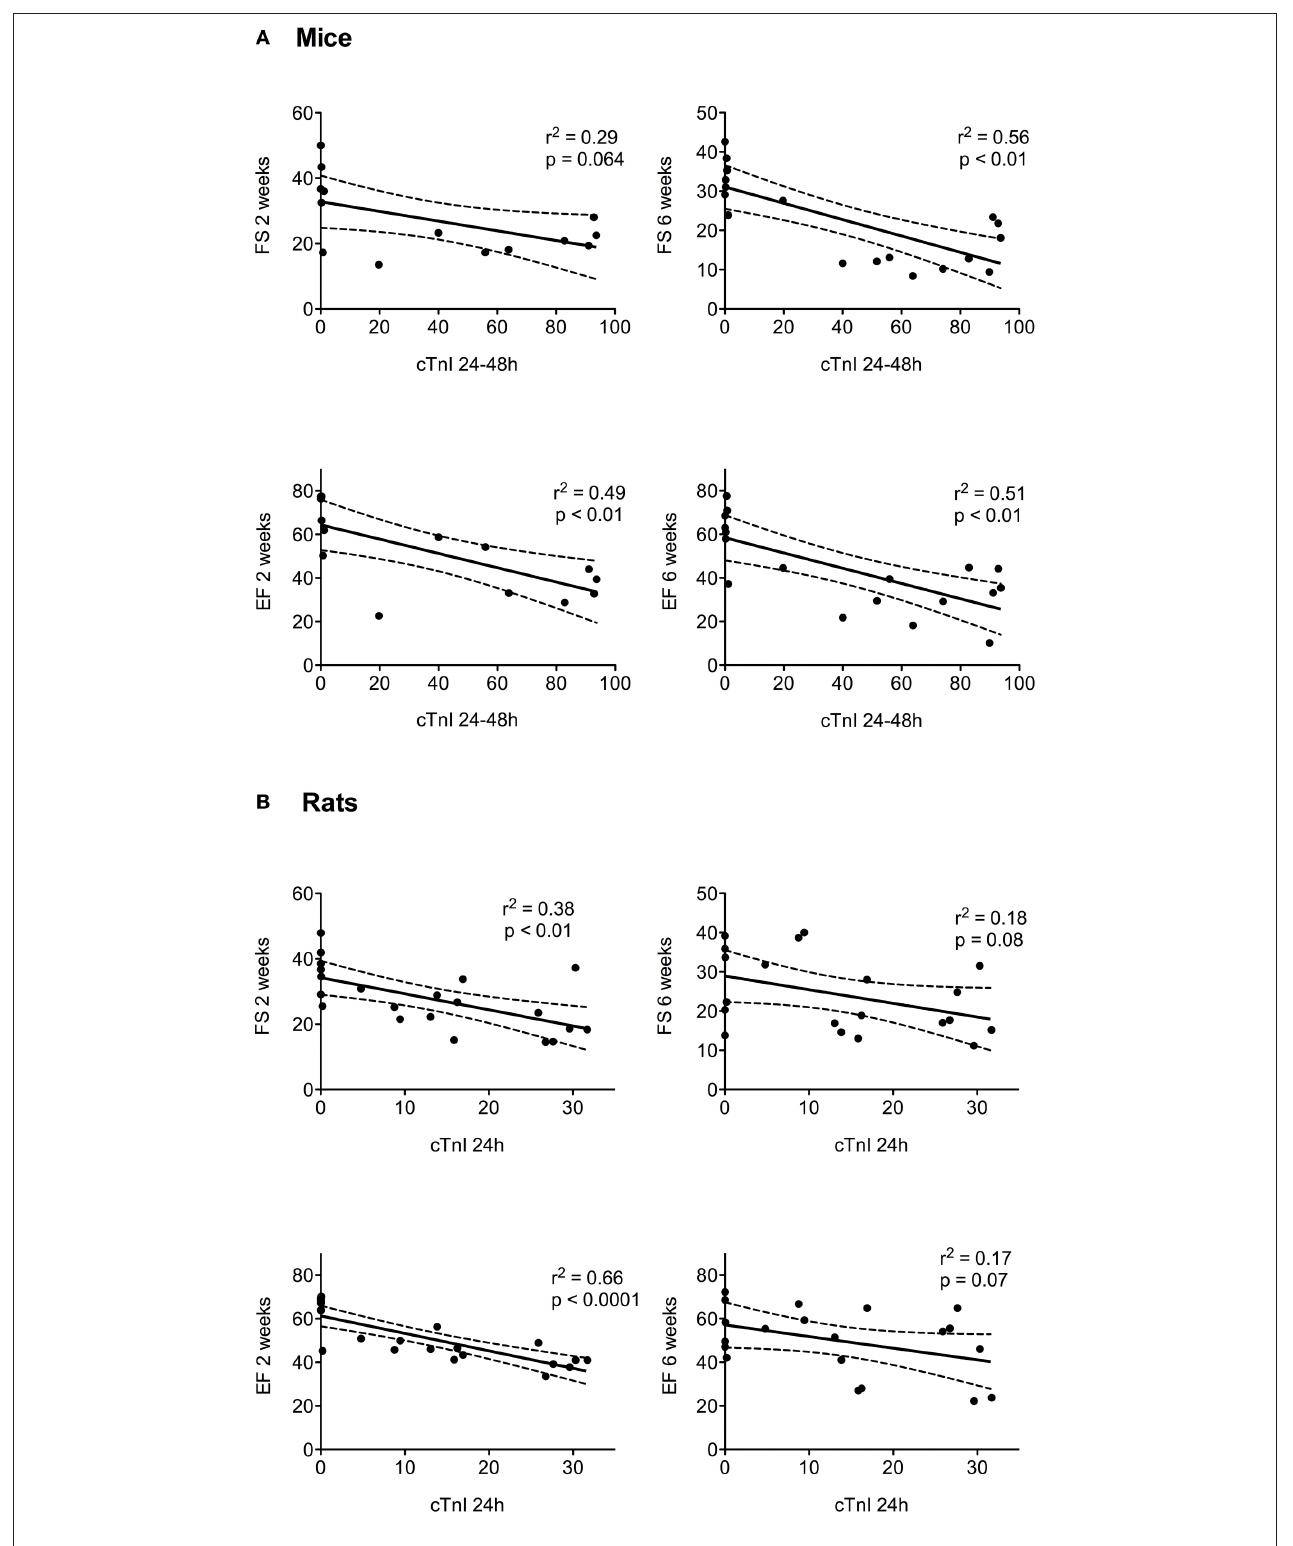
FIGURE 5 | The relationship between heart function (FS and EF) at 2 and 6 weeks after surgery and cTnI levels are represented as the mean value at 24–48h for mice (A) and the level at 24h for rats (B). The r 2 and p -values from the regression and correlation analyses are shown for each graph. The linear regression (black line) and 95% confidence intervals (dotted lines) are represented.